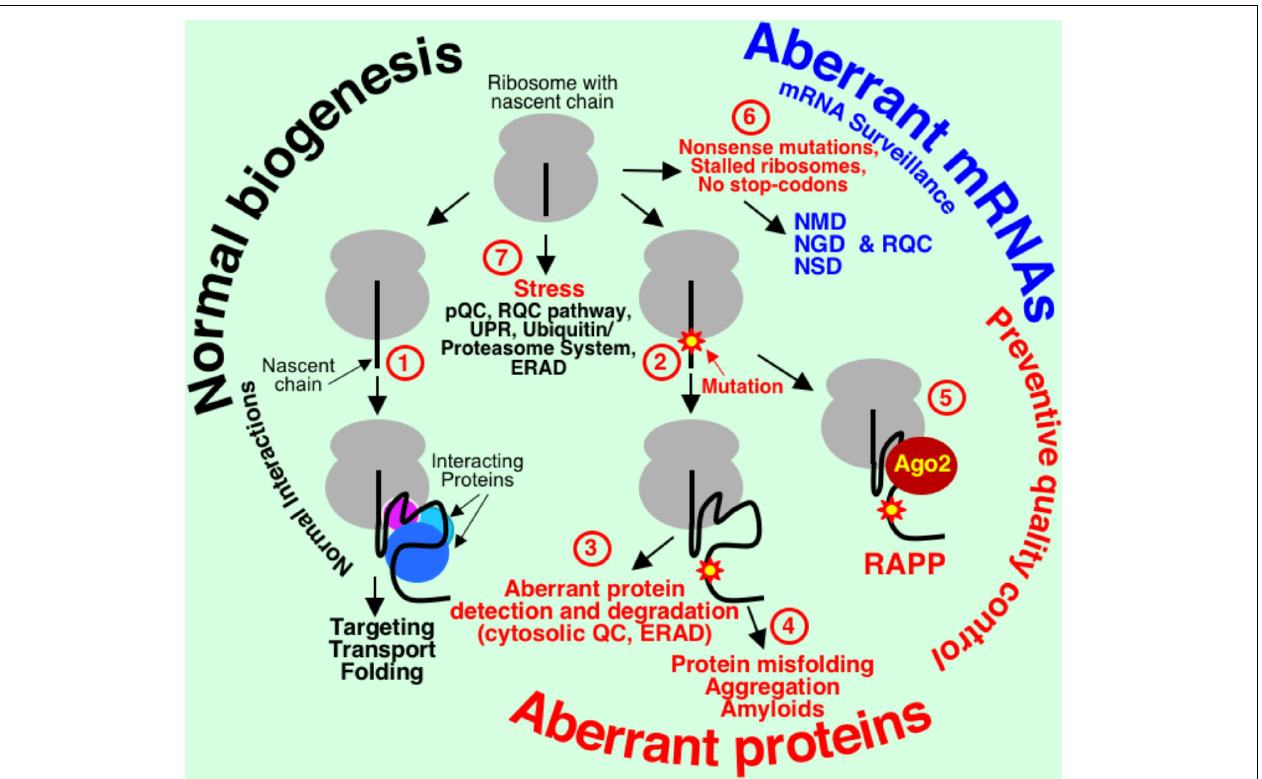
FIGURE 1 | mRNA and protein quality control pathways in mammalian cells. Normal interactions of the nascent chains lead to proper protein transport/folding (1). Loss of these interactions due to defect in the interacting factor or mutation in the polypeptide nascent chain (2) leads to protein degradation (3), misfolding, aggregation, and amyloid formation (4), or mRNA elimination in the RAPP pathway (5). mRNA surveillance quality control systems (6), nonsense-mediated decay (NMD), non-stop decay (NSD), and no-go decay (NGD) detect and eliminate defective mRNAs with PTCs, mRNAs without natural stop codon, and mRNAs at the stalled in translation ribosomes, respectively. Nascent chains at the stalled ribosomes or during stress are ubiquitinated in the ribosome quality control complex (RQC) pathway and removed by proteasome. During ER stress pre-emptive quality control (pQC) cotranslationally reroutes secretory and membrane proteins to cytoplasm for degradation. Many proteins are misfolded during stress and they are removed by multiple cellular systems, like UPR, ERAD, and ubiquitin/proteasome system (7).